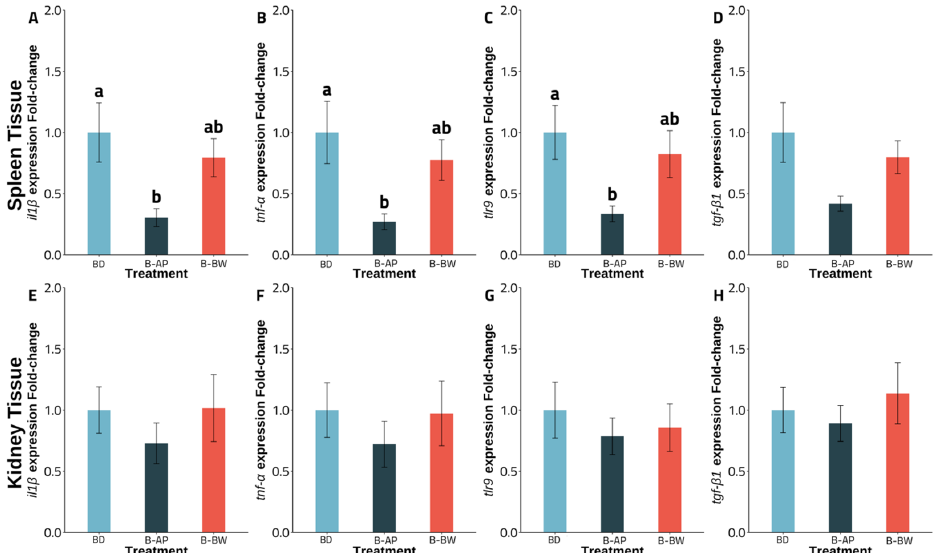
Figure 1. Gene expression of channel catfish from experiment A fed basal (BD; n = 5), B. velezensis AP193 (B-AP; n = 4), or BiOWiSH FeedBuilder Syn3 (B-BW; n = 6) probiotic-amended diet during a 6-week period with the initial weight of 34.80 ± 12.53 g. Different letters indicate a significant treatment difference ( p < 0.05). Bar graphs presented as mean and error bars, as standard error of the mean. BD = basal diet, B-AP = B. velenzesis included, B-BW = BiOWiSH FeedBuilder Syn3 included. Figure ( A – D ): Expression of il1 β ( A ), tnf- α ( B ), tlr9 ( C ), and tgf- β 1 ( D ) of spleen tissue. Figure ( E – H ): Expression of il1 β ( E ), tnf- α ( F ), tlr9 ( G ), and tgf- β 1 ( H ) of kidney tissue.